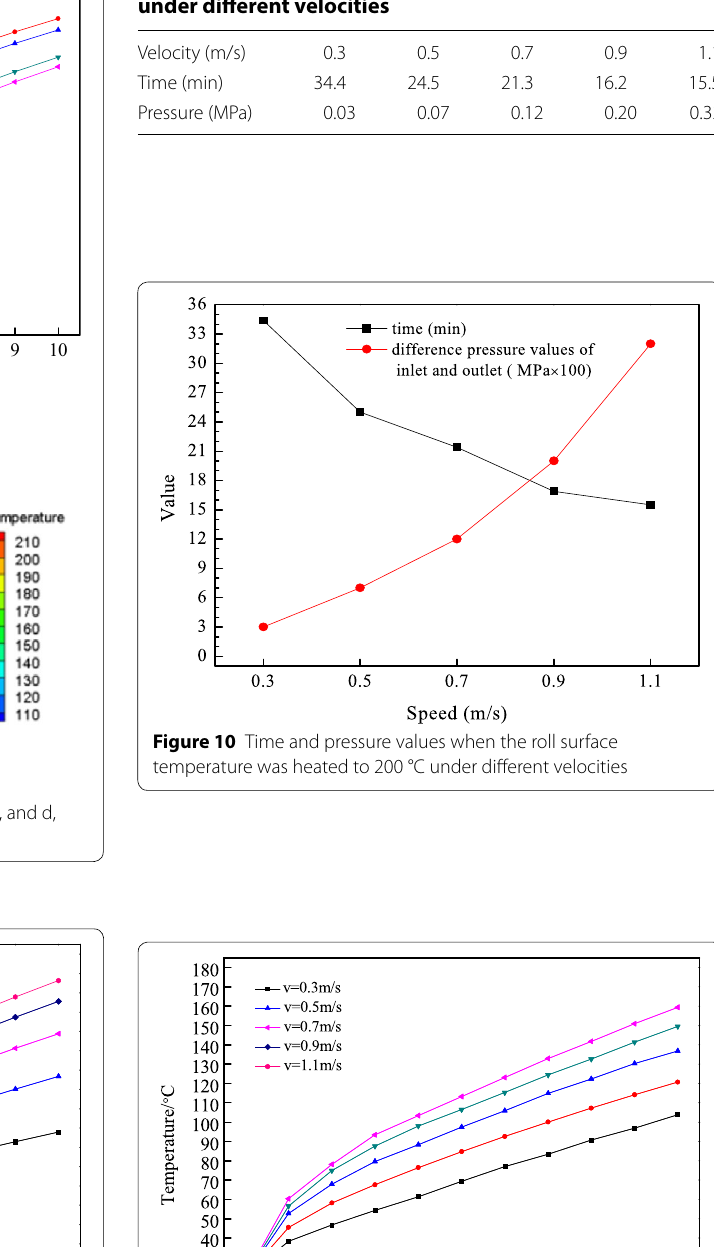
Table 5 Time and pressure values up to 200 °C